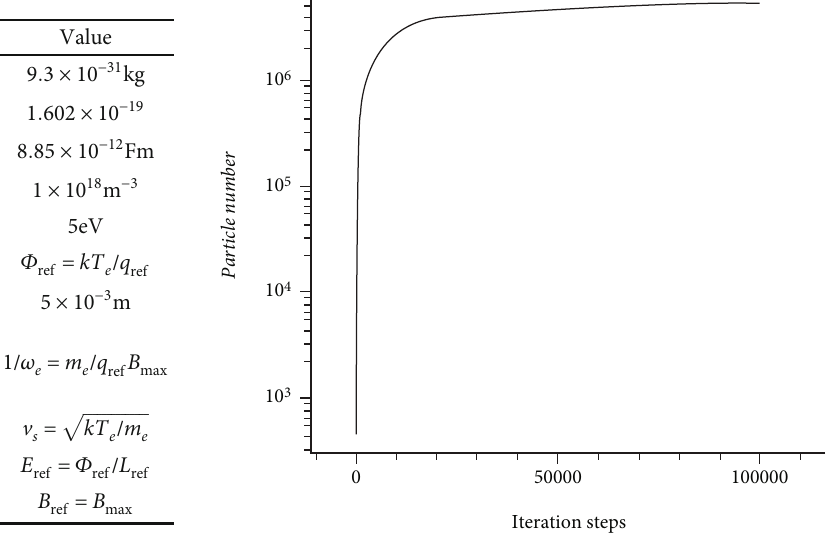
Figure 7: The curve of particle number with iteration